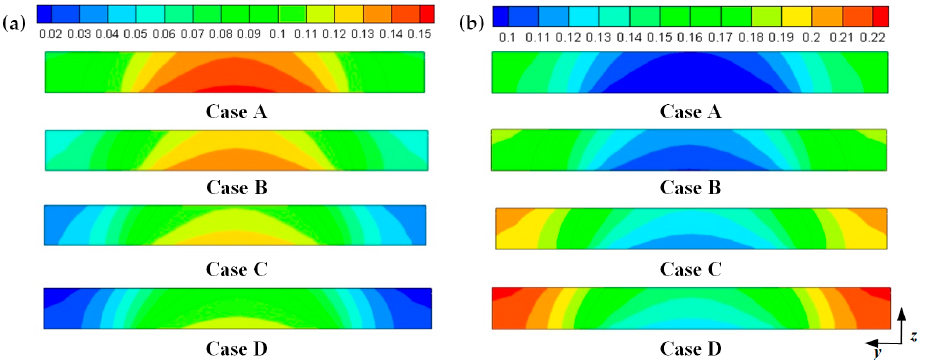
Figure 5. Species mass fraction at the middle plane of fuel cells (Case A: DL = 5; Case B: DL = 7; Case